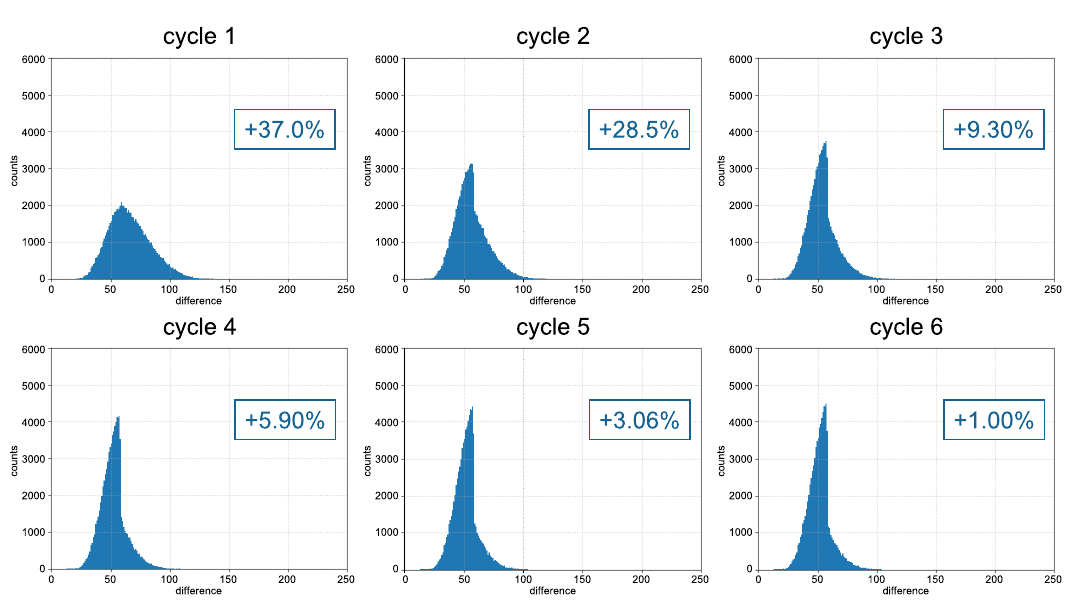
Figure 5. Evolution of the difference score histogram for DS2. The blue boxes show the percentage of the total gathers that went to the group good in each